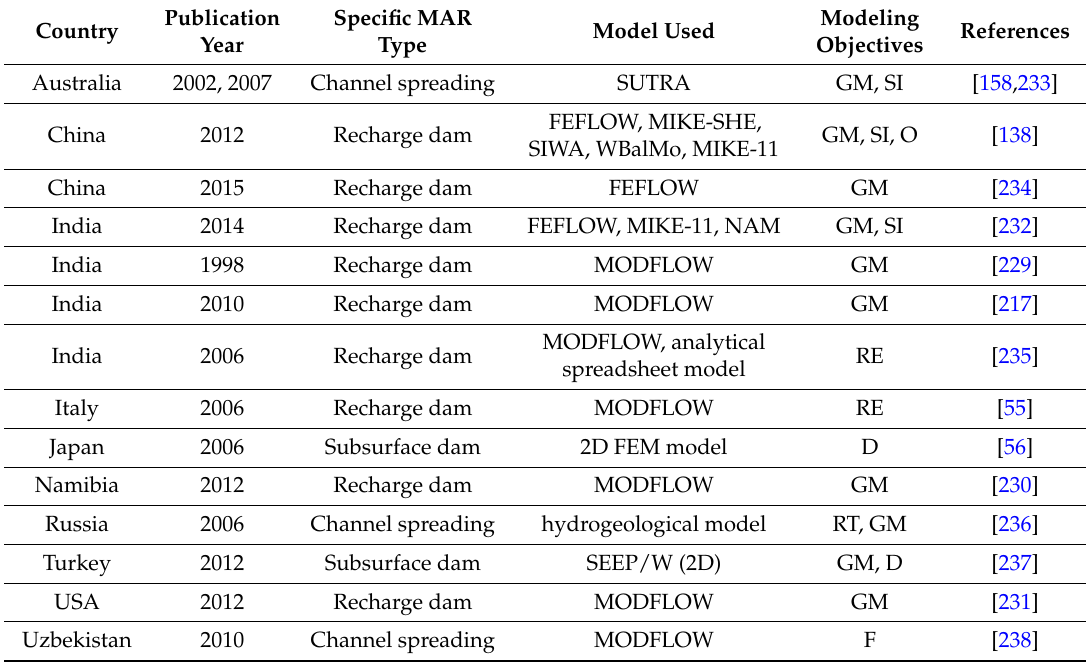
In-channel modifications modeling studies.